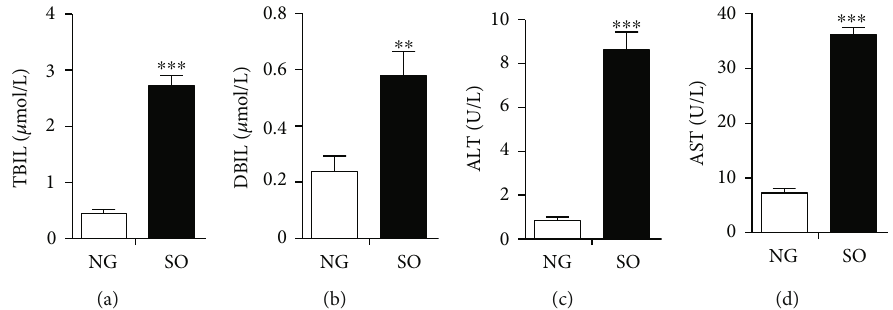
Figure 2: Biochemical parameters of BRL cells after treatment with SO. (a) The content of total bilirubin (TBIL) in cell medium. (b) The content of direct bilirubin (DBIL) in cell medium. (c) The content of alanine aminotransferase (ALT) in cell medium. (d) The content of aspartate aminotransferase (AST) in cell medium. NG: not given (BRL cells untreated with SO). The data was presented as mean ± SD , ∗∗ P < 0 : 01 , ∗∗∗ P < 0 : 001